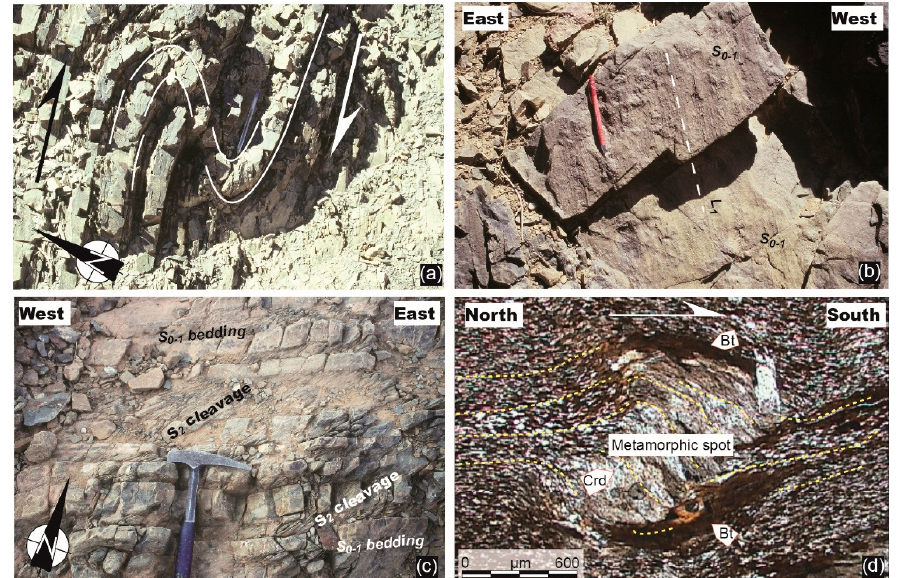
Figure 4. ( a ) Drag fold from the Qal’at Mgouna metagreywacke inlier. ( b ) Regional S 0 – 1 metamorphic foliation and related lineation marked by elongate contact metamorphic minerals that affect the metagreywacke sequence. ( c ) S 2 cleavage refraction, from the Imiter metagreywacke inlier, consistent with a dextral shearing. ( d ) Microphotograph showing syn ‐ to late kinematic metamorphic mineral, a probable cordierite (Crd) showing rolling structure consistent with a top ‐ to ‐ the ‐ south shearing sense. Note the asymmetric tails composed of biotite (Bt), plane polar light.